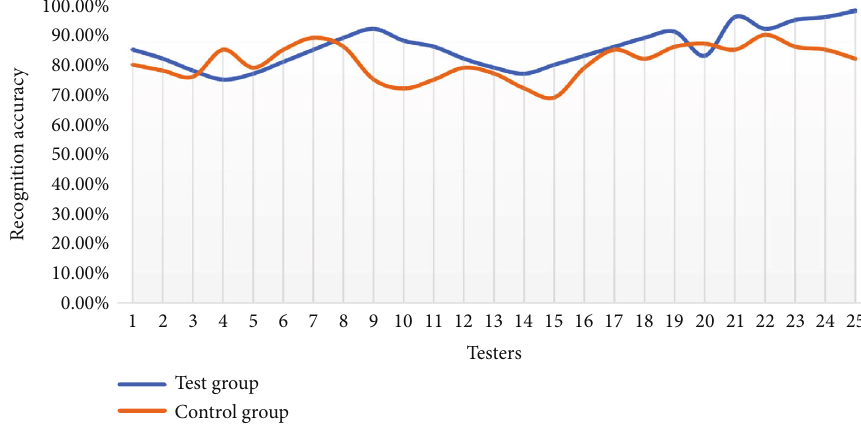
Figure 4: Facial recognition in low-light environments.